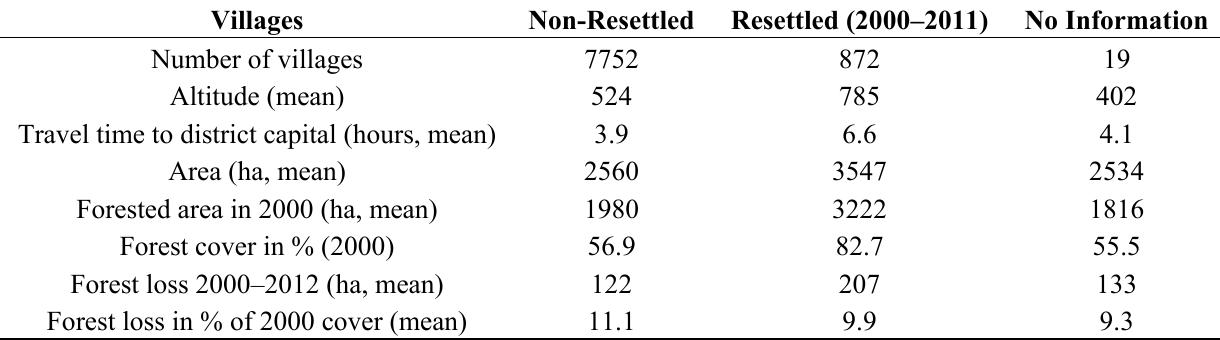
Table 2. Characteristics of resettled vs. non-resettled villages in